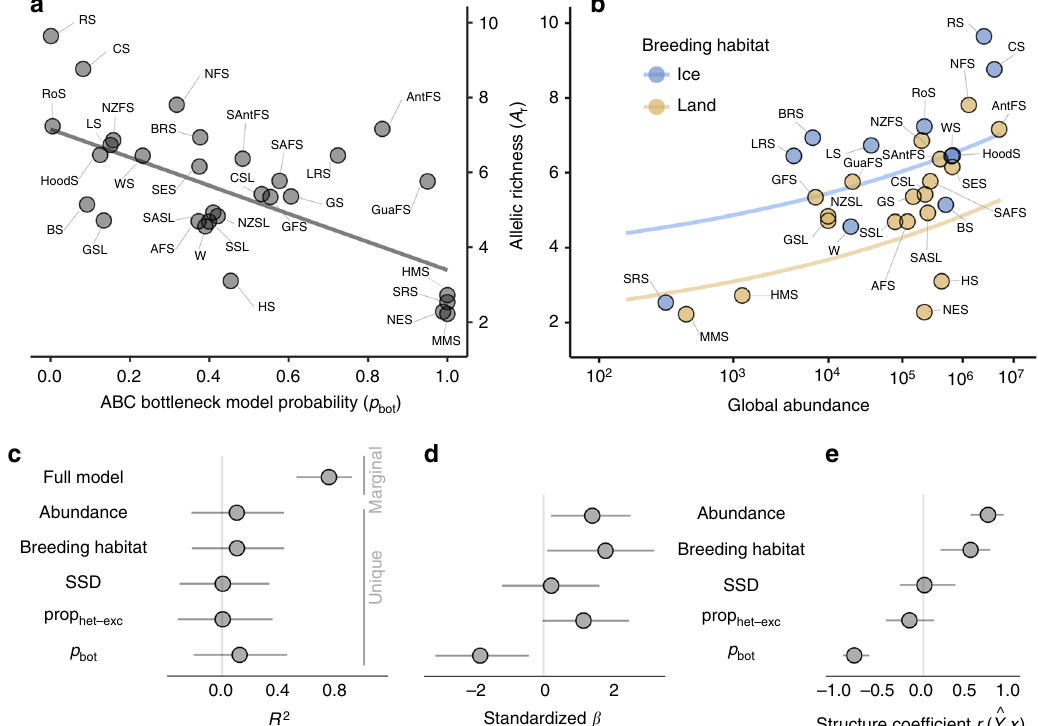
Fig. 4 Determinants of contemporary genetic diversity across pinnipeds. a Shows a scatterplot of A r versus p bot with the grey line representing the model prediction. b Shows the relationship between global abundance and allelic richness ( A r ) with the blue and yellow lines representing model predictions for ice-breeding and land-breeding seals respectively. Marginal and unique R 2 values, standardised β estimates and structure coef fi cients for the model are shown respectively in c – e , where they are presented as posterior medians with 95% credible intervals. Species abbreviations are given in Fig. 1 and